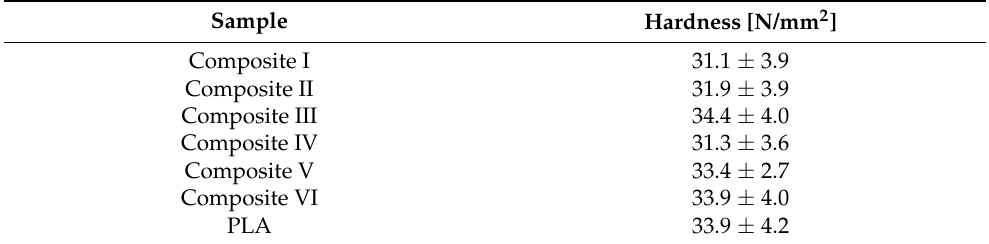
Table 6. Rockwell hardness test